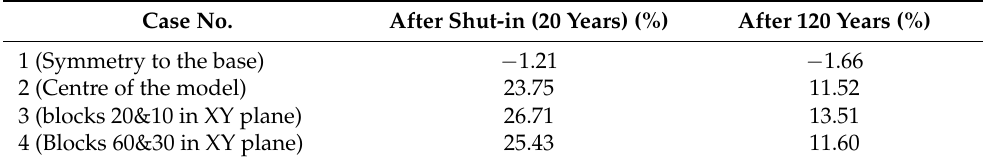
Table 6. Difference in CO 2 dissolution by changing well location compared to the base case. Case No. After Shut-in (20 Years) (%) After 120 Years